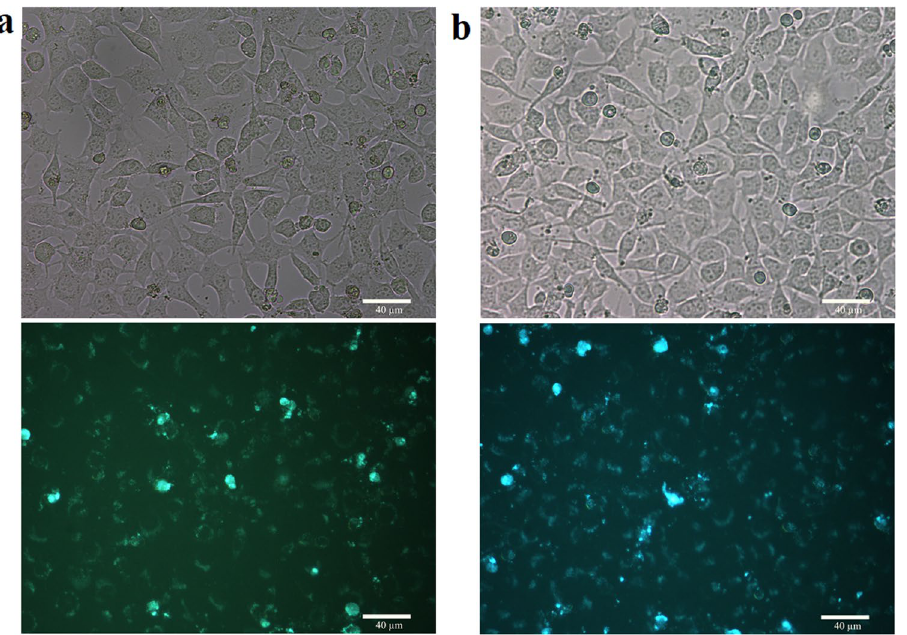
Figure 7. Fluorescence microscopy images of the Mouse C34/connective tissue-L929 cells with CQDs as the fluorescent probes; bright-field images on the top and fluorescent images on the bottom for ( a ) 1% and ( b ) 3% of the